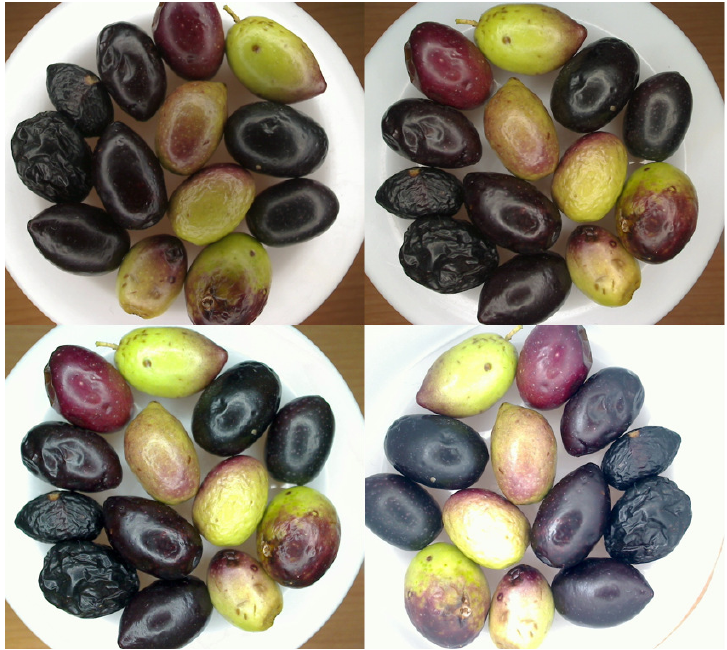
Figure 2. Difference in brightness with different